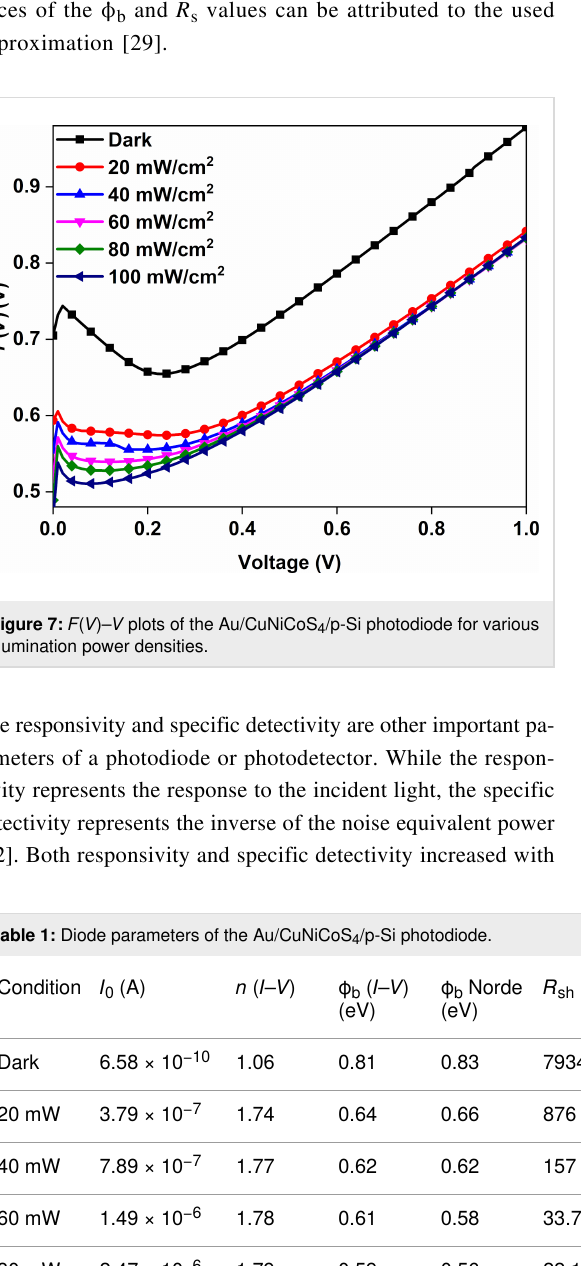
where V 0 is the minimum voltage corresponding to F ( V ). F ( V ) versus V plots of the Au/CuNiCoS 4 /p-Si photodiode are shown in Figure 7 for different illumination power densities. The calculated ϕ b and R s values are given in Table 1. The F ( V )– V plots represent normal Norde function plots, and the F ( V ) values decreased with increasing light power, especially in the low-voltage region due to the increasing photocurrent. The ob- tained values of ϕ b and R s are in good agreement with the ϕ b and R s values derived from thermionic emission. Small differ- ences of the ϕ b and R s values can be attributed to the used approximation [29].